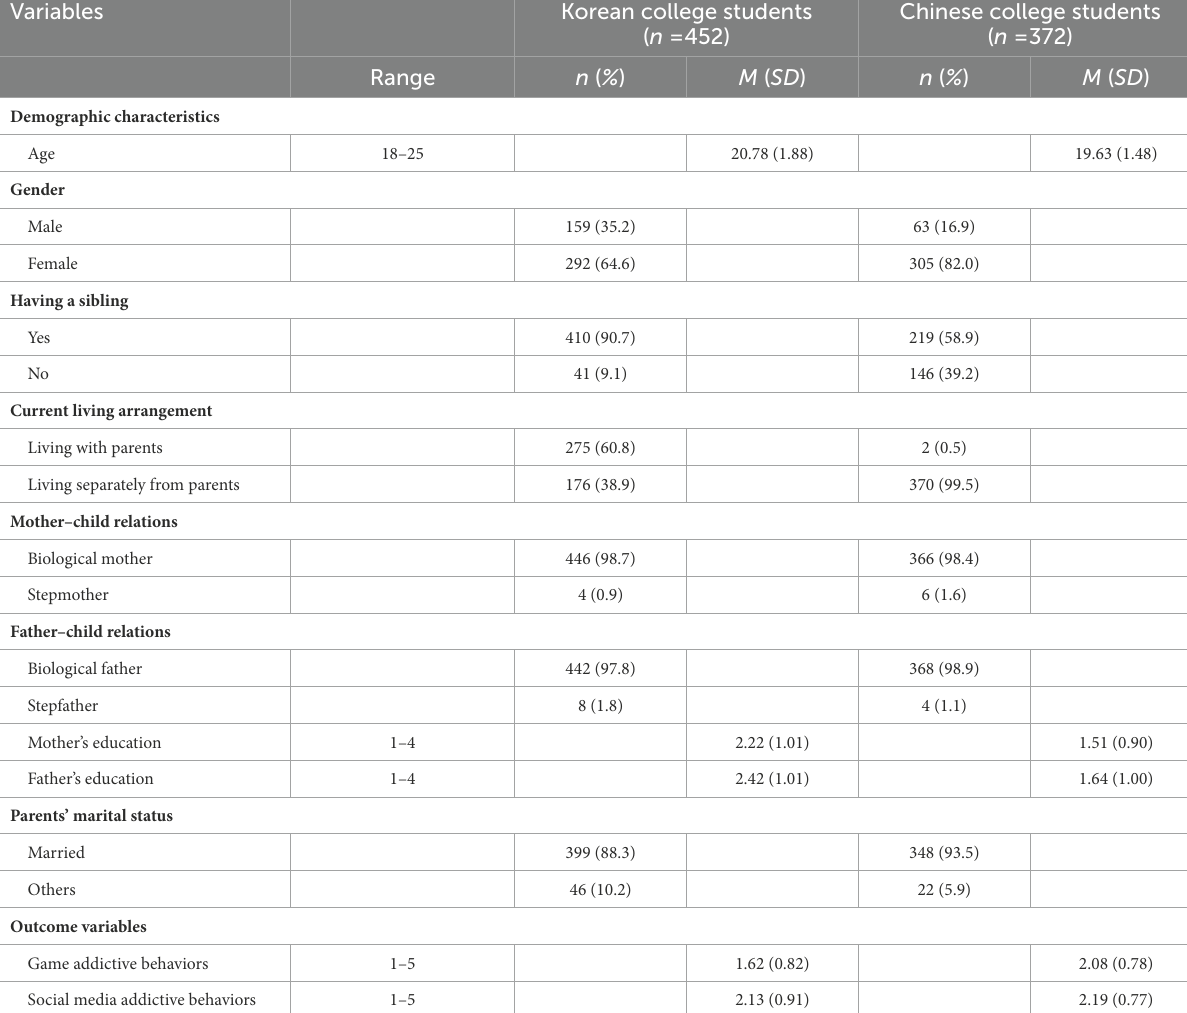
TABLE 2 Descript results of demographic characteristics and game and social media addictive behaviors in Korean and Chinese college